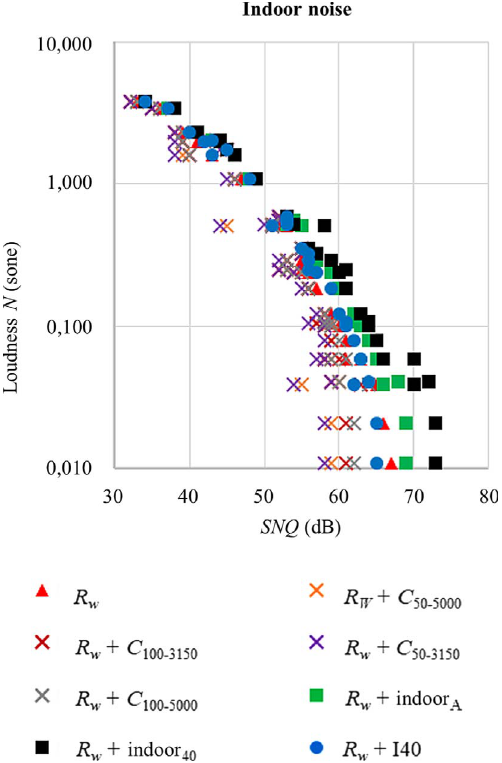
Figure 6. Correlation between the Zwicker ’ s Loudness of transmitted sounds (in case of pink noise at the emitting side) and values of 8 SNQs for the tested